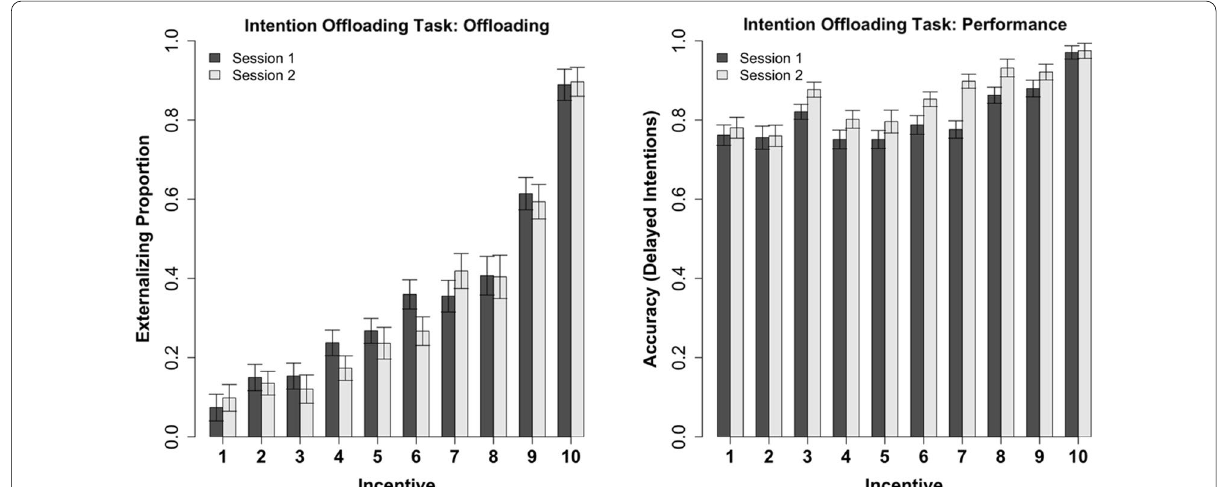
Fig. 6 Group-level analysis of offloading behavior (externalizing proportion) and performance (accuracy of fulfilling delayed intentions) for the intention offloading task. Incentive refers to the number of points a participant received for correctly fulfilling a delayed intention object (offloaded or not). When the incentive was below 10, participants earned additional bonus points for using their memory instead of